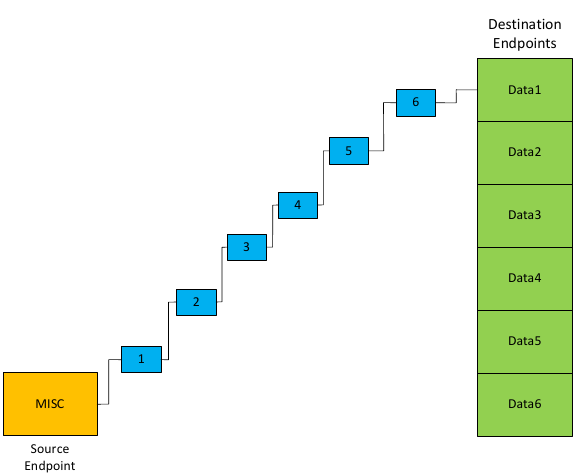
Figure 4. Tree Optimizer Phase 1